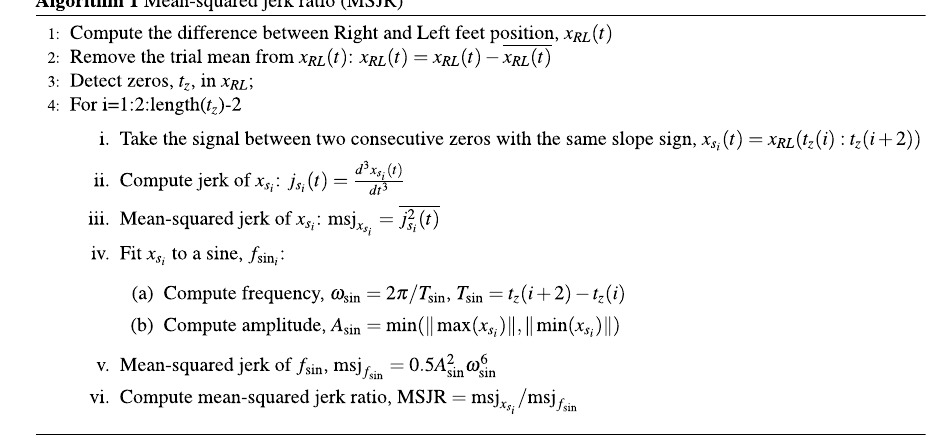
Guiard 33 defined the concept of harmonicity as a measure of rhythmicity or discreteness for movements of ( t ) and compared with the MSJR. Consider a window the (single) upper limb. Harmonicity is computed on x s i defined by two consecutive zero-crossings in displacement and extract the maximum and minimum accelera- tion peaks in the window. If there is only one peak, harmonicity is 1; if the maximum and minimum peaks have opposite signs, harmonicity is 0; otherwise, harmonicity is defined as the ratio between the absolute value of the minimum and the maximum acceleration peaks. As harmonicity approaches 0, the movement is considered to be predominantly discrete, whereas more rhythmic movements will have values closer to 1. The plot of the right versus left foot forward position results in a figure-8-like spatial pattern. An orbit is defined between the points where the distance between the feet is zero ( x RL = 0 ) and the slope of the relative position function x RL ( t ) has the same sign. The algorithm to compute the angle, dPCA, between the principal component of two consecutive orbits is described in Algorithm 2. As done to compute the MSJR, we take the relative position between right and left foot along the trial, x RL ( t ) , and remove the mean. Then, consecutive zero-crossings in ) . A principal component , x i x RL ( t ) with the same slope sign are used to segment the right-left foot orbit ( x i Rs Ls analysis (PCA) is performed on this orbit to extract the first principal component vector, v i PCA . Finally, the angle